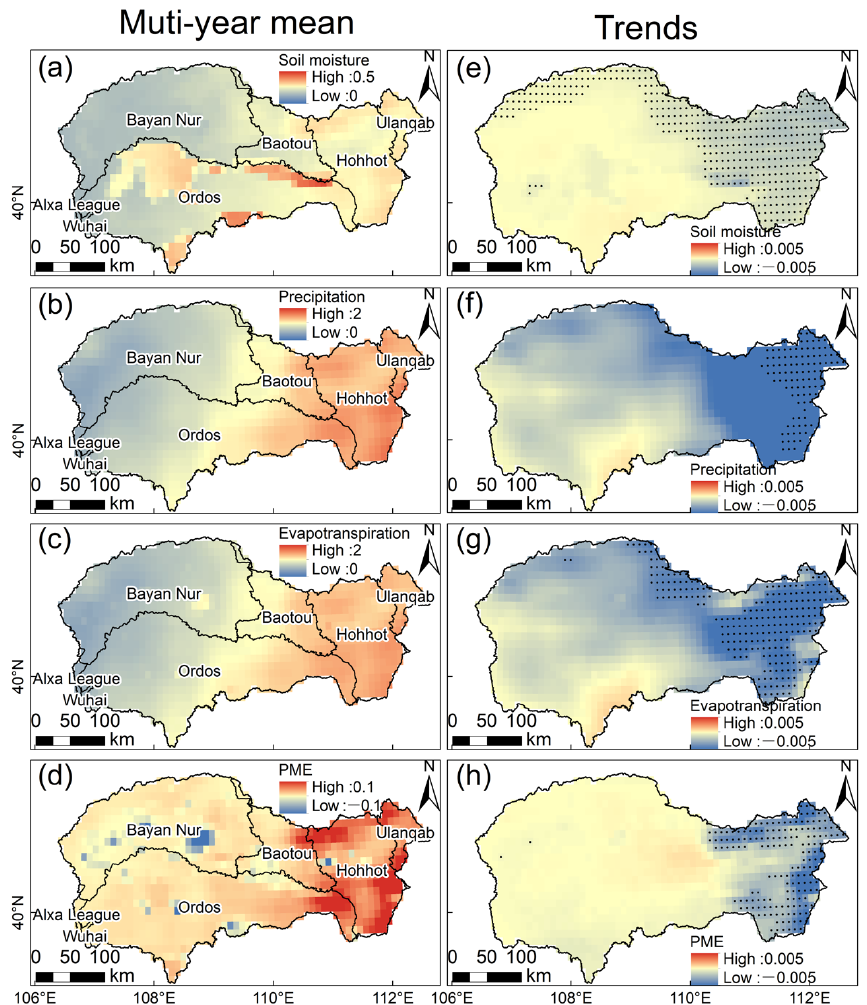
Figure 3. Spatial patterns and trends of soil moisture (( a ) cm 3 /cm 3 and ( e ) cm 3 /cm 3 per year), precipitation (( b ) mm and ( f ) mm per year), evapotranspiration (( c ) mm and ( g ) mm per year) and PME (( d ) mm and ( h ) mm per year) from 1980 to 2021, stippling denotes regions where correlation coefficients are significant at the 95% confidence level. Table 2. Long-term monthly mean value and interannual trends in soil moisture (SM), precipitation (P), evapotranspiration (E) and precipitation minus evapotranspiration (PME). Sensitivity coeffi- cient of 1 indicates that increases by 100% of its standard deviation when last month SM increases by one standard deviation. (* p < 0.05, ** p < 0.01, *** p < 0.001).